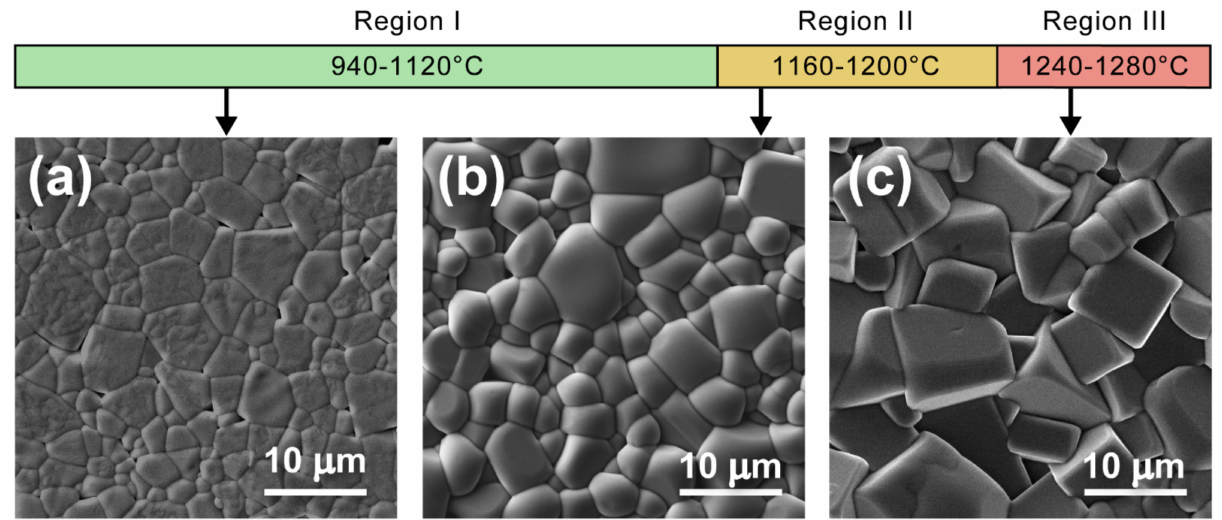
Figure 1. Division of the whole thermal treatment temperature range into three thermal treatment regions, as well as examples of SEM micrographs characterizing each of them: flat microstructure, obtained by thermal treatment at 980 ◦ C— Region I ( a ); microstructure with well-pronounced relief, obtained by thermal treatment at 1200 ◦ C—Region II ( b ); cube-like microstructure, obtained by thermal treatment at 1240 ◦ C—Region III ( c